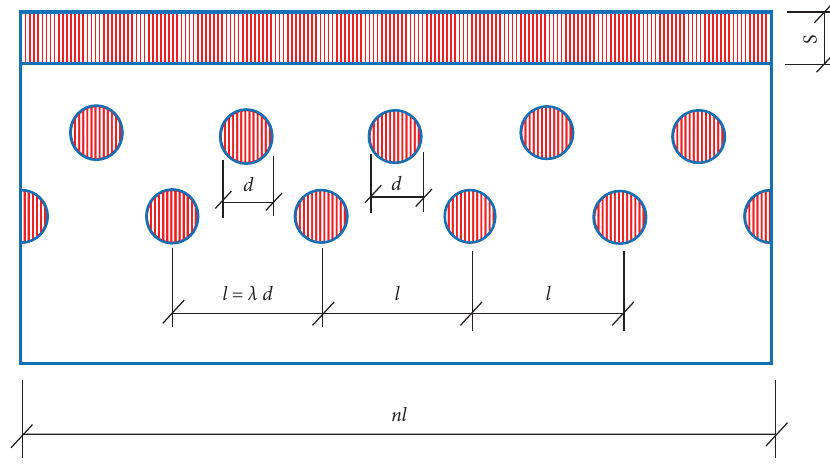
Figure 5: Analysis sketch for diameter of the digging